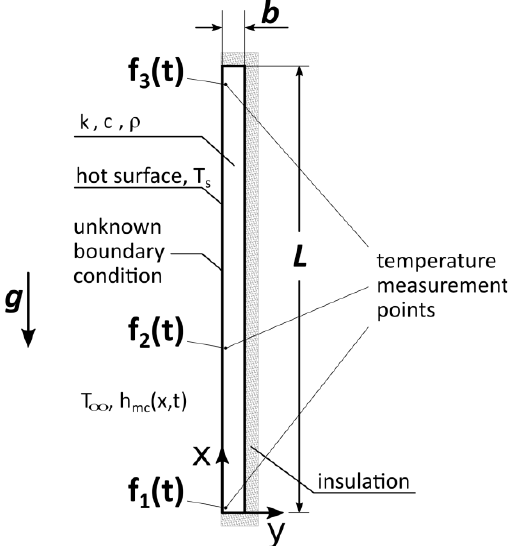
Figure 4. A plate exposed to mixed convection.